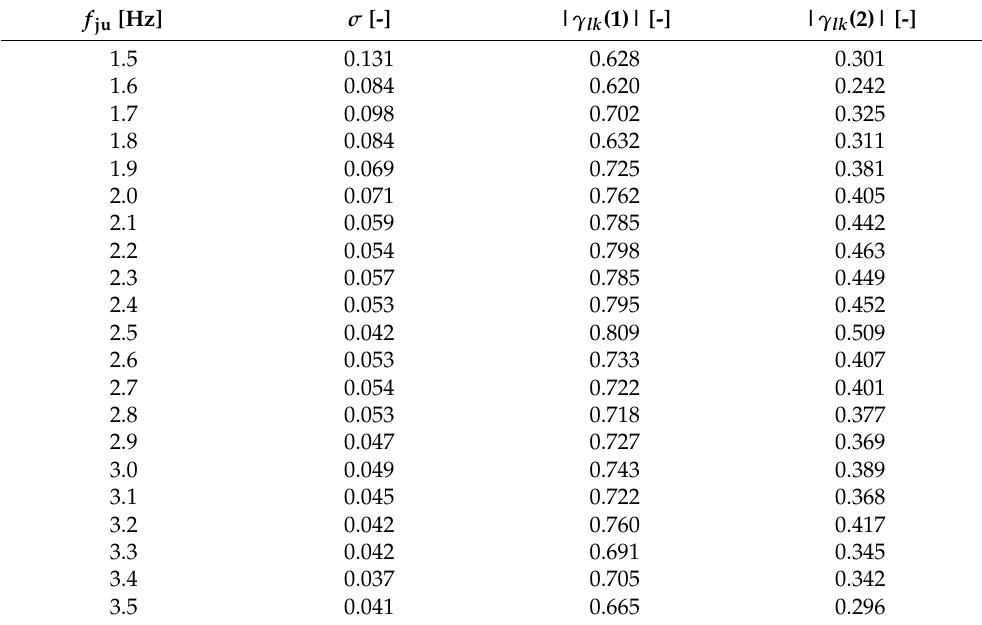
Table 3. Model coefficients for the cross-PSD.